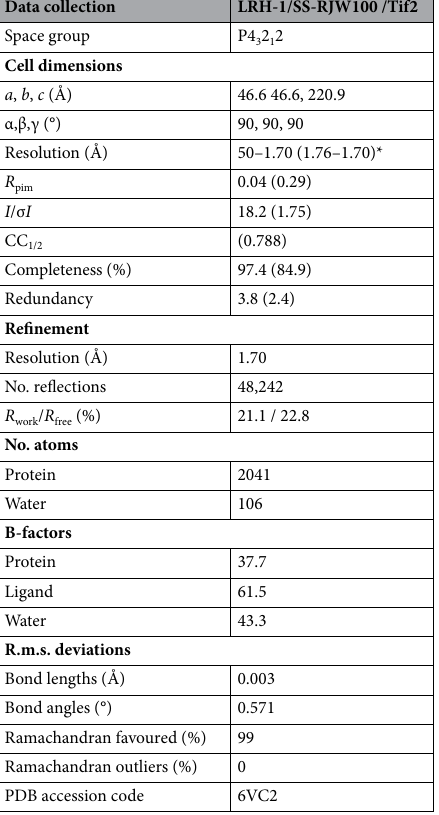
Table 1. X-ray data collection and refinement statistics. *Values in parenthesis indicate highest resolution